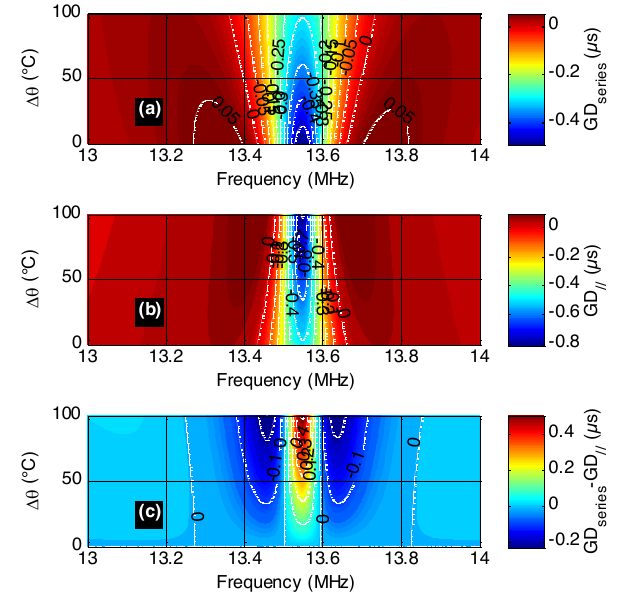
FIGURE 6. Thermo-frequency variable mappings of (a) RLC-series, (b) RLC- parallel VTF GDs and (c) their algebraic difference from the circuits shown in Figs.